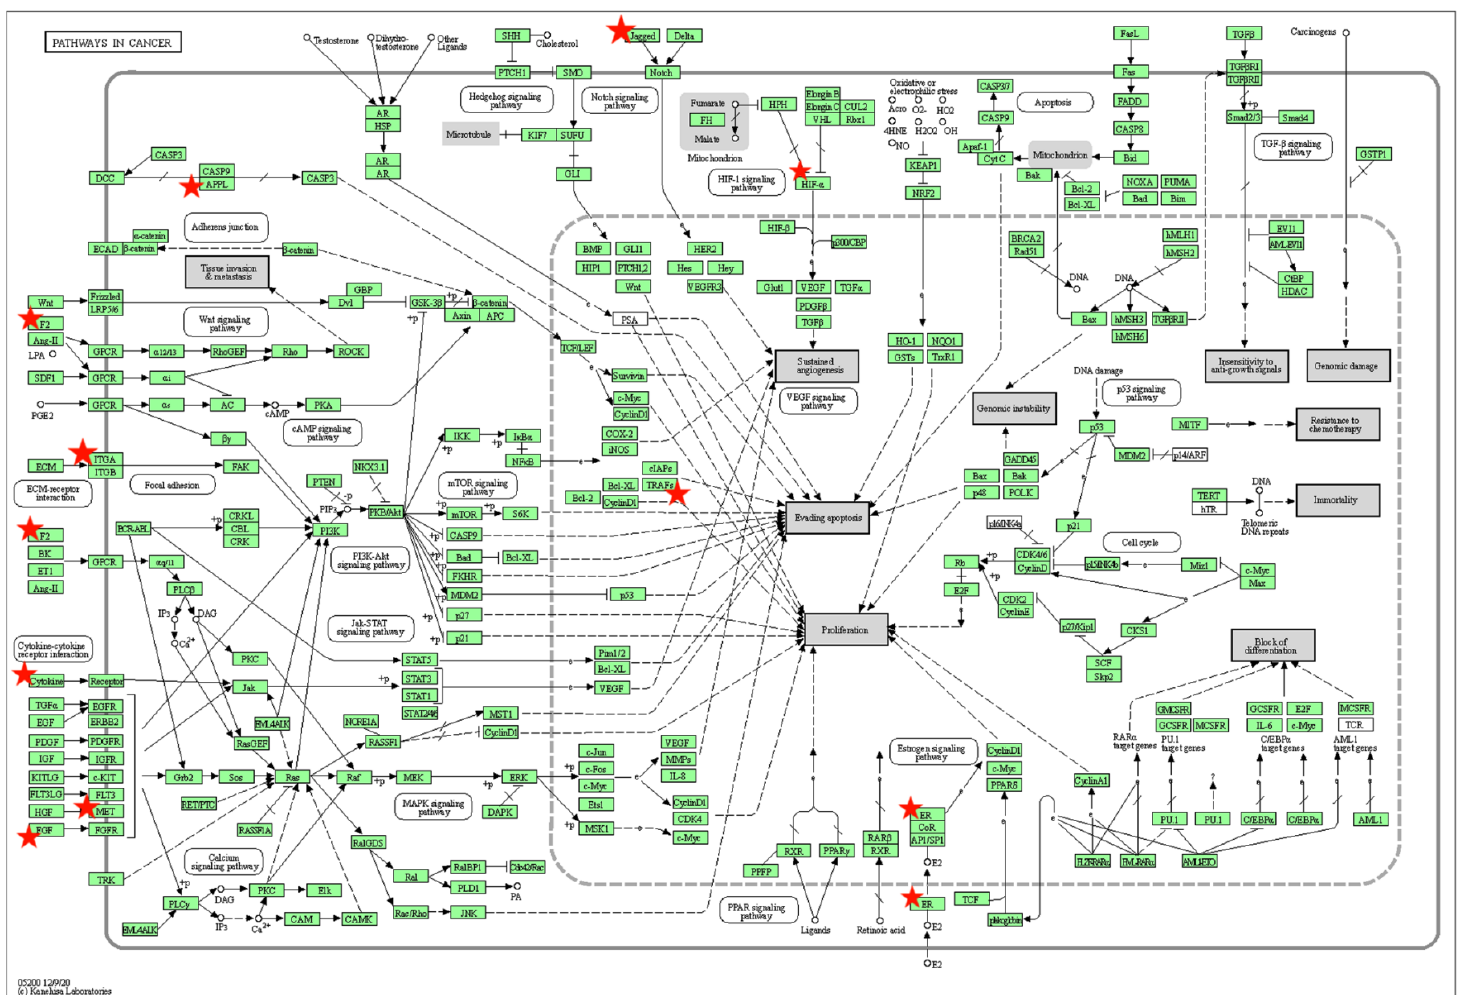
Figure 3. Enriched “Pathways in cancer” in Canine Mammary Tumors. Predicted target genes for oncogenic and oncosuppressor miRNAs are marked with red star, including 5 target genes for miR-146b (MET; TRAF6; APPL1; F2; IL12A); 3 predicted genes for both miR-18a and miR-18b (ESR1; HIF1A; ITGA6) and 2 predicts for miR-21 (FGF18;